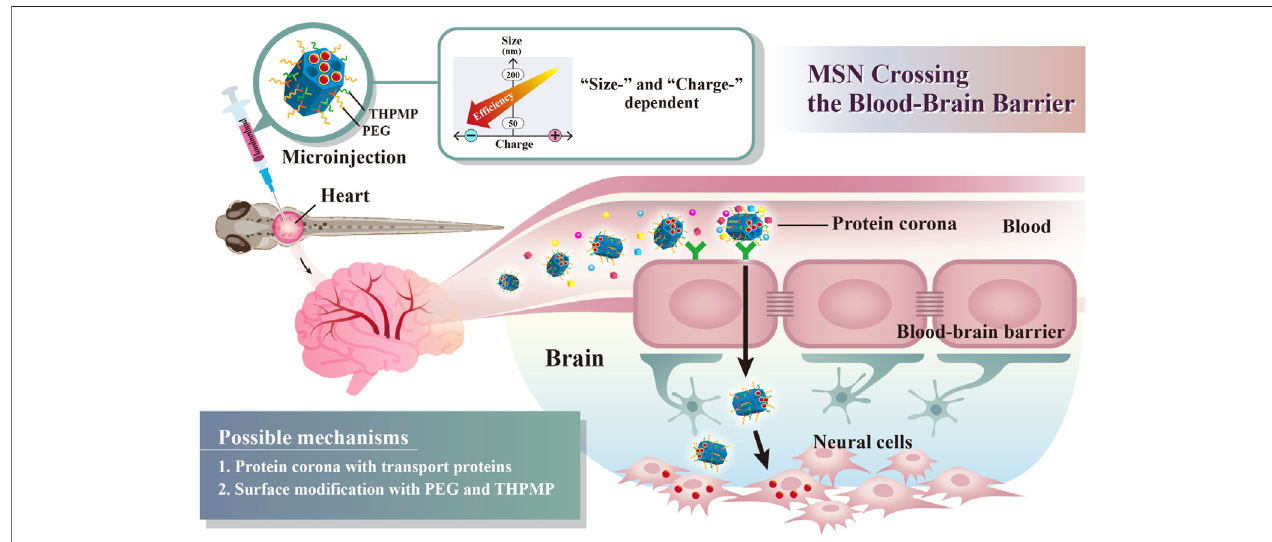
(dpf) embryos from Tg ( z fl i1 :EGFP) zebra fi sh, which